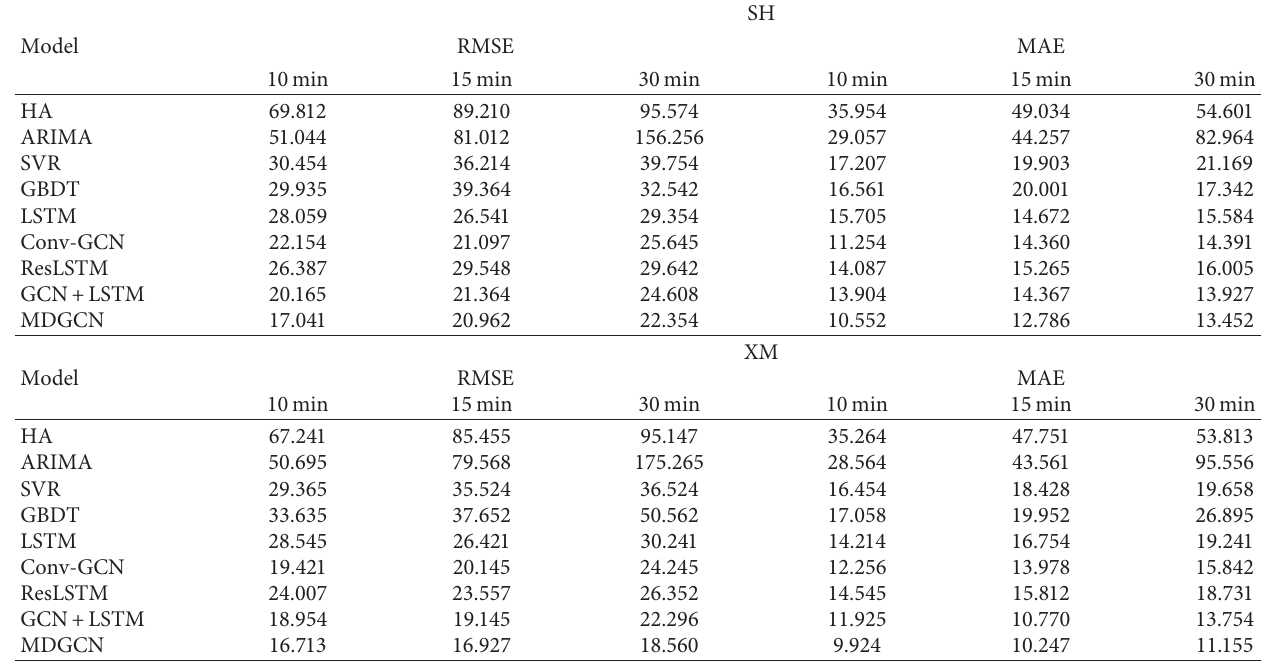
Table 3: The performance in different baselines.